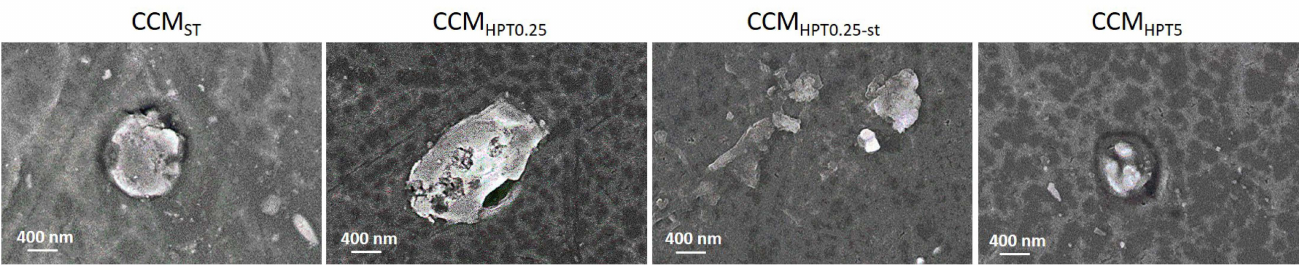
Figure 6. The cored surfaces of the samples at the extensive stage of polarization. Nyquist and Bode plots of the tested samples are presented in Figure 7 with fitted data and R ox and C ox in Table 3 according to the equivalent circuit used for CCM samples shown in Figure 8.